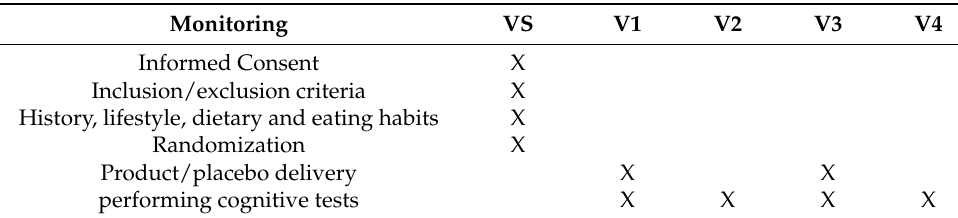
Table 1. Follow-up actions at each unit